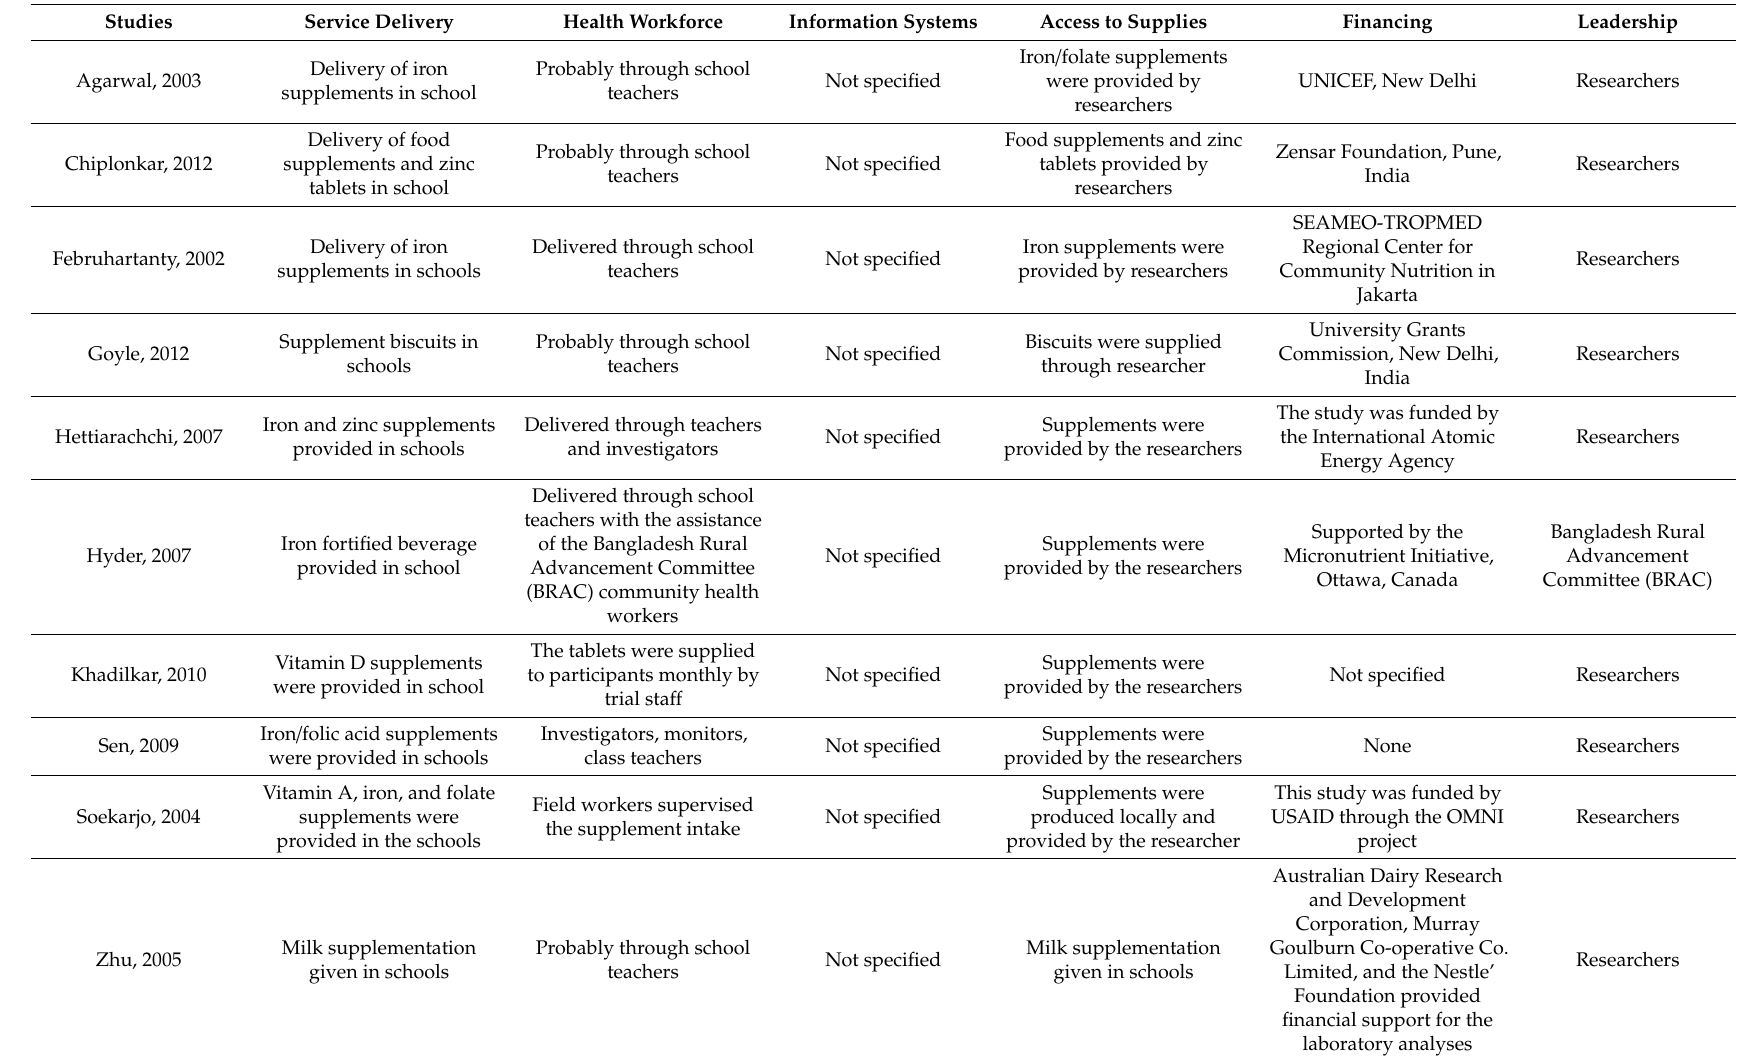
Table 2. World Health Organization (WHO) health system building blocks